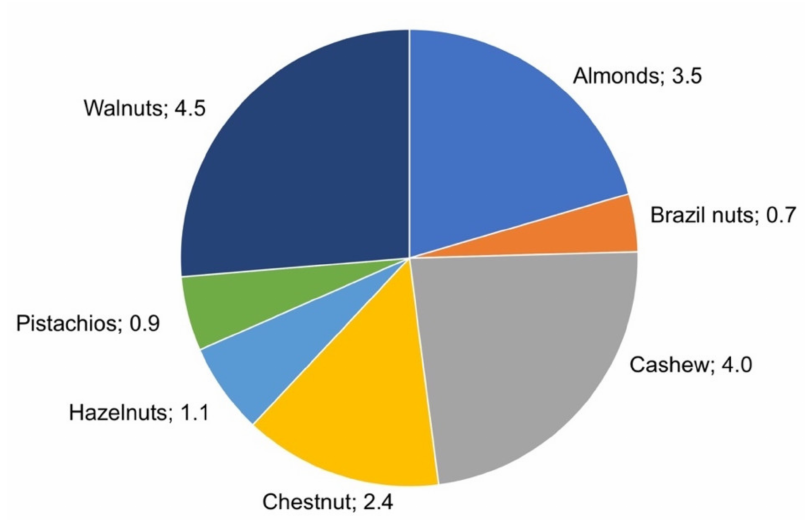
Figure 2. Worldwide nut production (Mtons) registered by FAOSTAT in